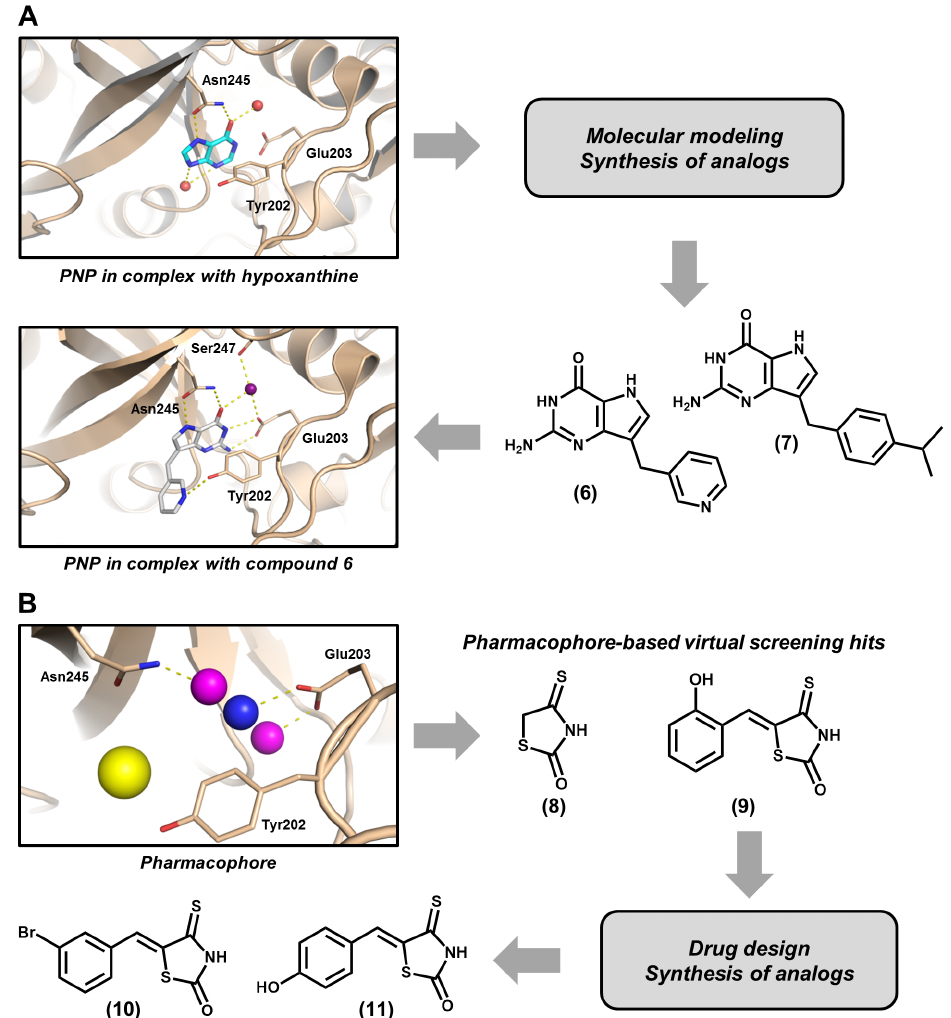
Figure 4 - Identification of Schistosoma mansoni purine nucleoside phosphorylase (PNP) inhibitors. ( A ) X-ray crystallography and molecular docking approaches to the discovery of purine analogs as highly potent S. mansoni PNP inhibitors. ( B ) Pharmacophore-based virtual screening used in the identification of thioxothiazolidinone derivatives as novel S. mansoni PNP